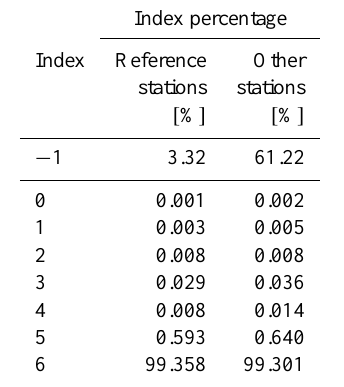
Table 2. Percentage of the different indexes obtained after the QC procedures. Note that to maintain a good comparison between both types of stations, the “missing data” are not included in the index percentage of index 0 to 6.